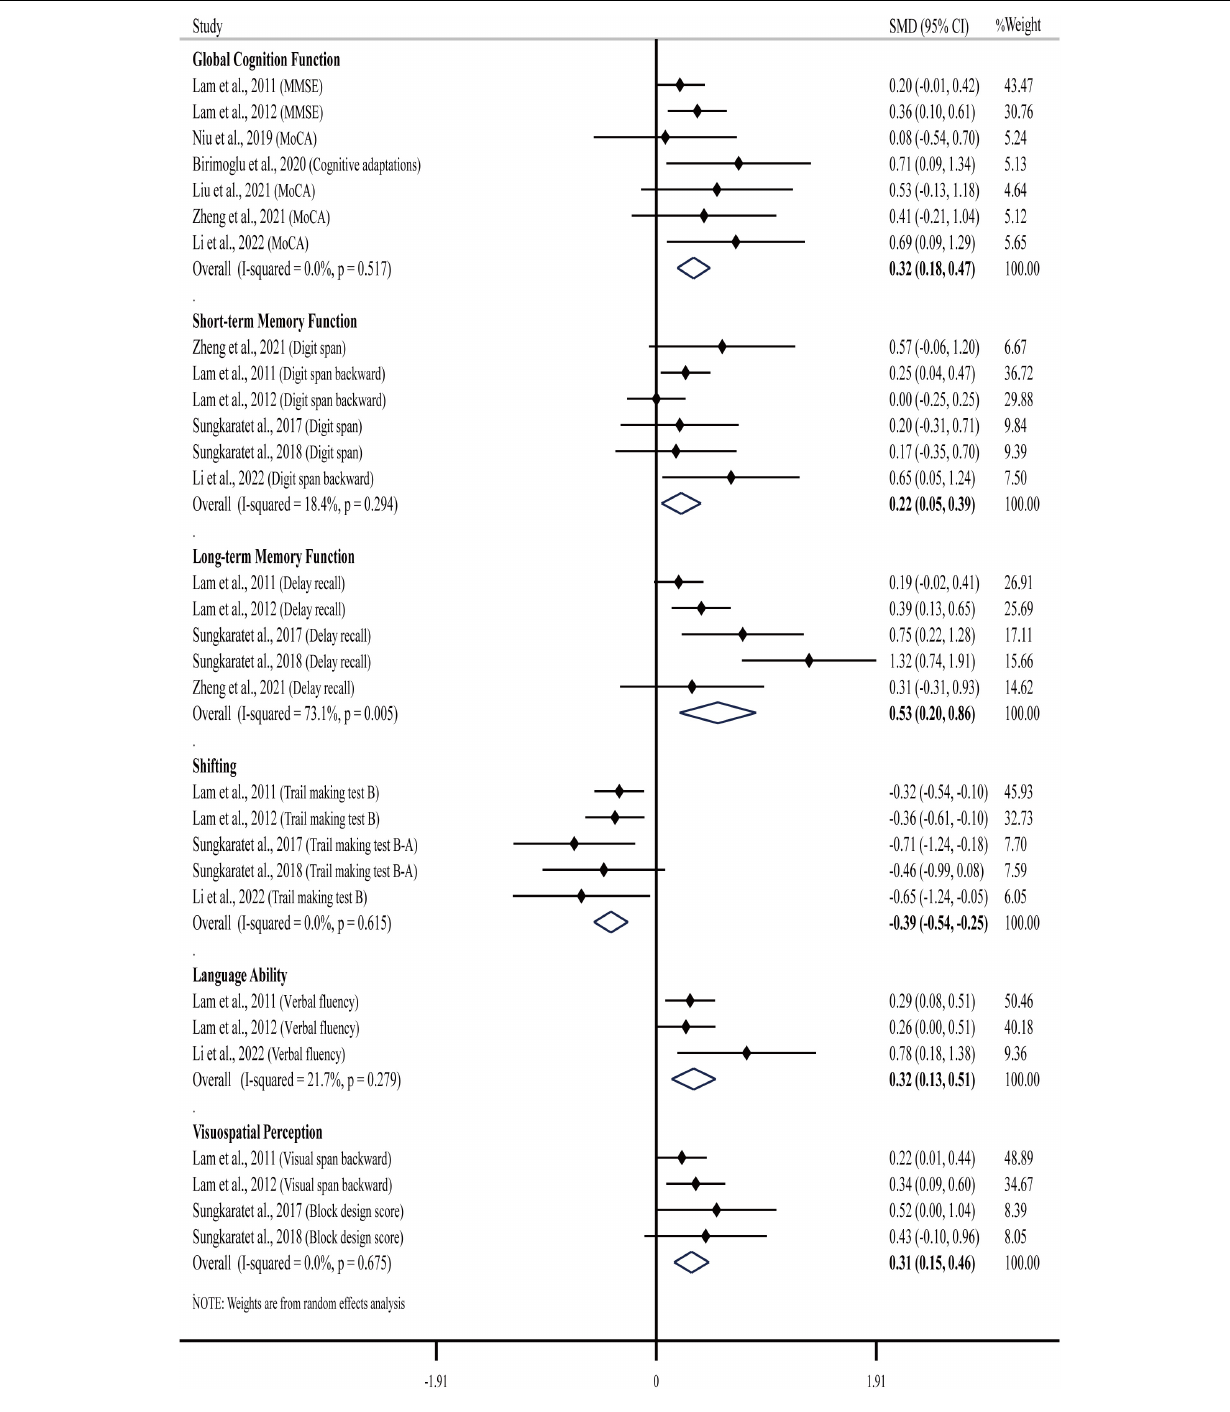
both longer duration ( ≥ 24 weeks, SMD = − 0.38, 95% CI −